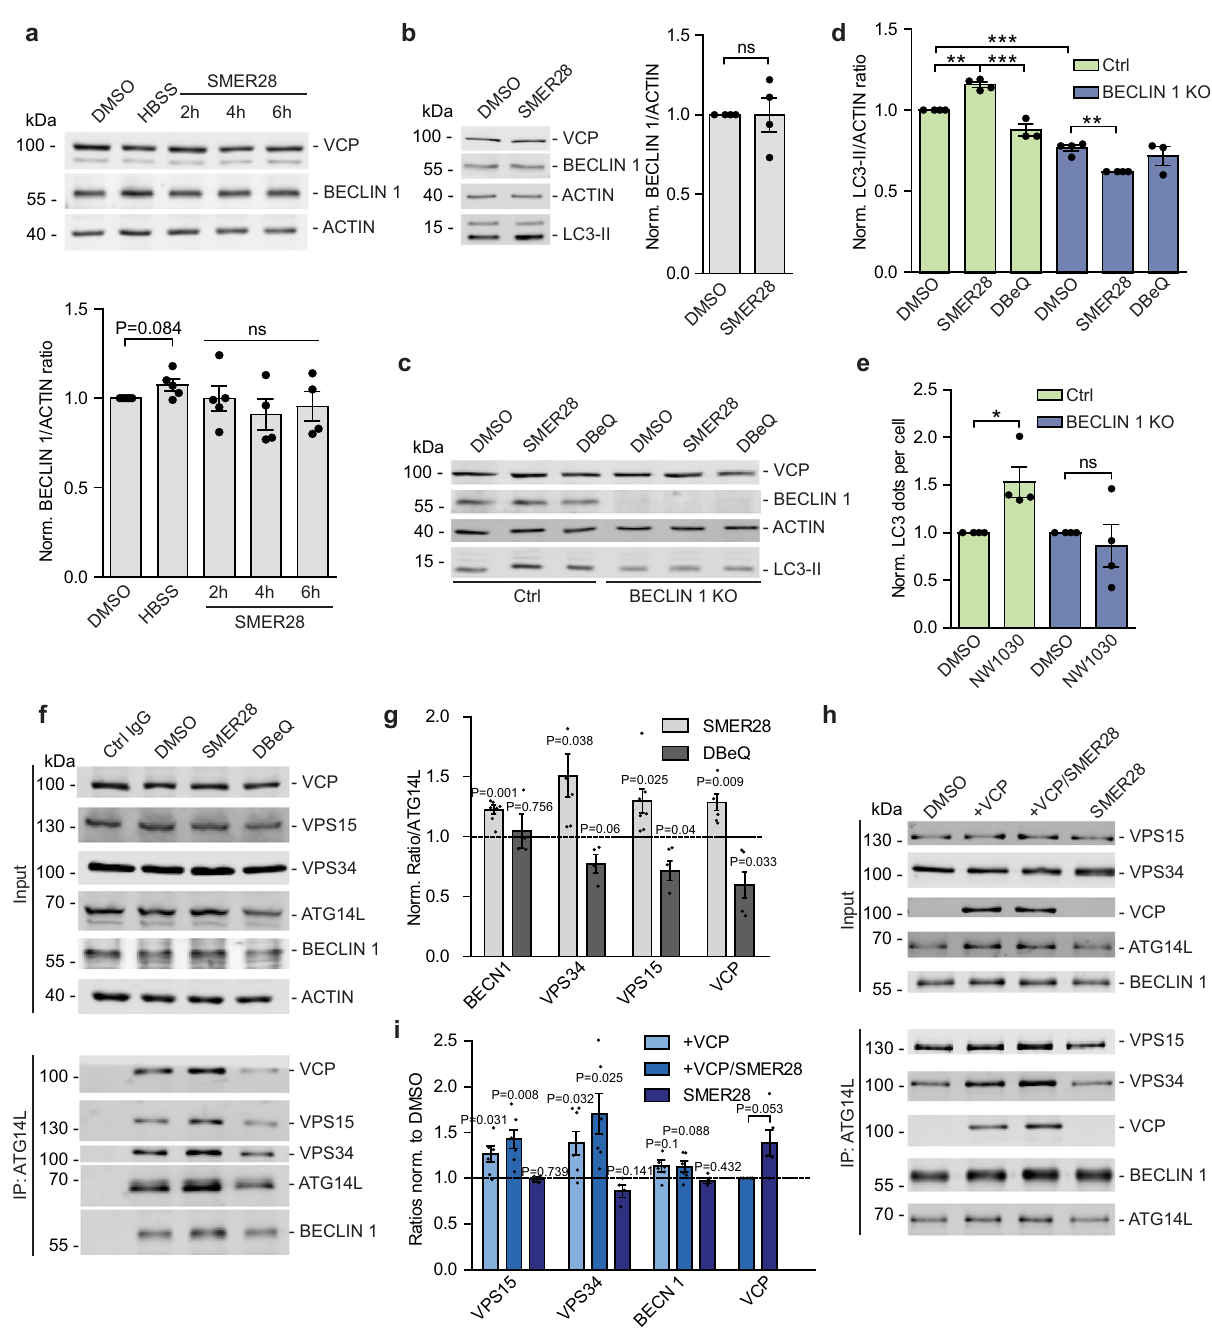
Fig. 5 SMER28 enhances VCP stimulation of PI3K complex formation to induce autophagy in a Beclin 1-dependent manner. a , b Beclin 1 levels in HeLa cells treated with 20 μ M SMER28 for 2, 4, or 6 hours. In the presence of 400 nM BafA1 b ; n = 5. c , d Beclin 1 knockout cells and control cells were pre- treated with 400 nM BafA1 for 1 h prior to treatment with 20 μ M SMER28 or 10 μ M DBeQ for 8 h in the presence of BafA1. LC3-II to actin ratios are quanti fi ed in d n = 4; one-way ANOVA: P < 0.0001 with post hoc Tukey test, Ctrl SMER28 P = 0.0027, DBeQ P < 0.0001, Ctrl vs. KO P < 0.0001, KO SMER28 P = 0.0057. e Number of LC3 puncta in Beclin 1 knockout cells and control cells. Cells were pre-treated with 400nM BafA1 for 1 h prior to treatment with 10 μ M NW1030 for 8 h; n = 4; control cells P = 0.0457, Beclin 1 knockout P = 0.5854. f , g Immunoprecipitation of endogenous ATG14L from HeLa cells treated with 20 μ M SMER28 or 10 μ M DBeQ for 6 h. Ratios of proteins co-immunoprecipitated with ATG14L in the denoted conditions, normalized to ratios in DMSO control in g n = 7. h , i In vitro assembly of PI3K complexes. FLAG-tagged PI3K components were added individually (VPS15 and VPS34 puri fi ed and added together) and incubated alone or together with puri fi ed VCP and/or 20 μ M SMER28, followed by immunoprecipitation of ATG14L. i Ratios of proteins co-immunoprecipitated with ATG14L in the denoted conditions, normalized to ratios in DMSO control. Quanti fi cation of VCP levels shows VCP/ATG14L ratios with and without the addition of SMER28, normalized to ratio without SMER28; n = 6. See also Supplementary Fig. 5c for differences in PI3K interactions with the addition of VCP with or without additional treatment with SMER28. f – i After protein transfer, PVDF membrane was cut and fragments were incubated with appropriate primary antibodies. Data presented as normalized mean ± SEM, * P < 0.05, ** P < 0.001, *** P < 0.0001, one sample t test unless stated otherwise; ns not signi fi cant, Ctrl control cells. Source data are provided as a Source Data fi